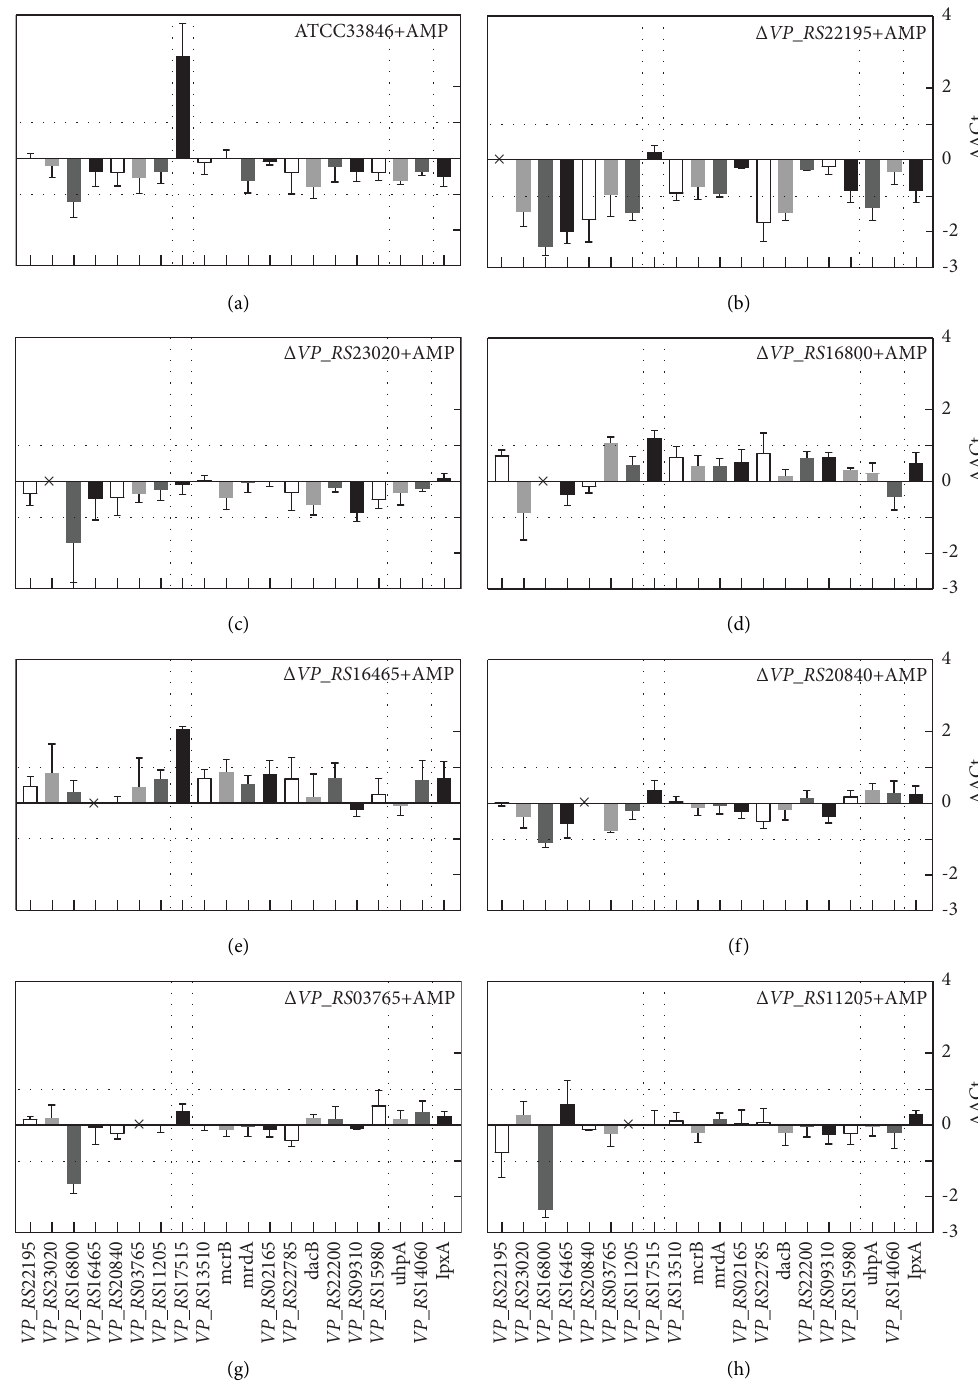
Figure 6: Comparison of transcription of 20 genes in the 7 V. parahaemolyticus OMP deletion mutants under stimulation of ampicillin (AMP), using wild-type ATCC33846 as a control. Five kinds of genes are divided by dotted line: OMP genes, β -lactamase genes, PG synthesis-related genes, stress-regulation-related genes, and lipid A synthesis genes. Te transcription change fold is calculated by 2 − ΔΔ Ct . Each bar represents the mean value of three biological replicates, and the error bars represent standard deviations calculated from three biological